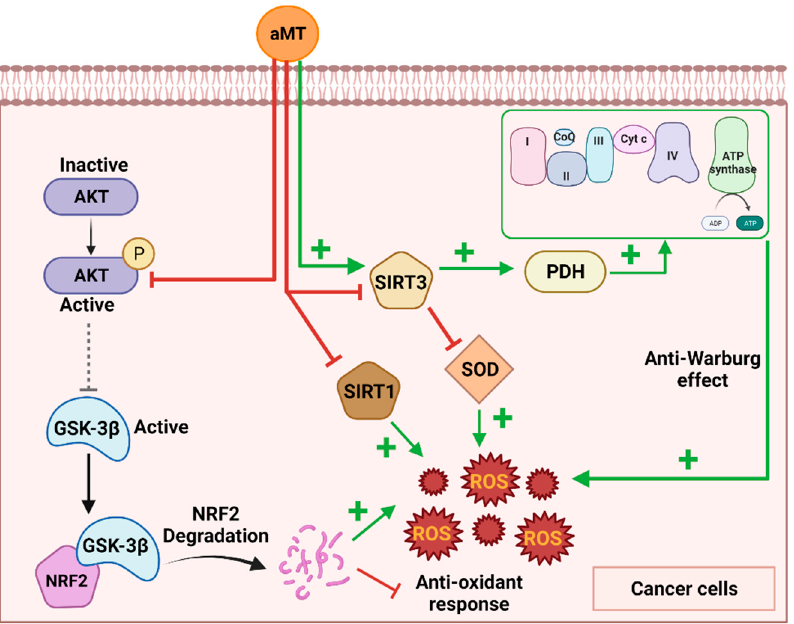
Figure 2. Different mechanisms by which melatonin induces ROS production in cancer cells. Melatonin inhibits the AKT pathway, leading to the activation of GSK-3 β , which induces NRF2 degradation. On the other hand, melatonin regulates Sirtuin 3 (SIRT3) through its activation or inhibition, leading to an anti-Warburg effect or SOD inhibition, respectively. Finally, melatonin has been shown to inhibit SIRT1 in cancer cells. All these processes lead to an increase in ROS production and antitumor activity. Melatonin (aMT); glycogen synthase kinase-3 β (GSK-3 β ); superoxide dismutase (SOD); pyruvate dehydrogenase (PDH). Image created using BioRender.com (accessed on 18 July 2022). SIRT-1, a conserved nicotinamide adenine dinucleotide (NAD+)-dependent